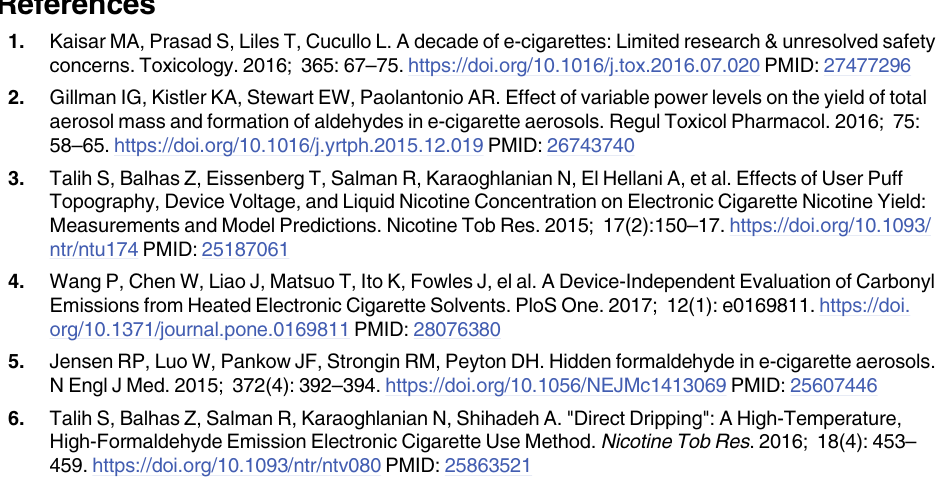
S1 Table. Corresponding statistic (Anova) for TC measurements presented in S3 Fig at the top and mid-section of atomizer B for the three different applied mods (mod_1, mod_2, mod_3) at the selected time points of: 1 s, 3 s, 5 s, 7s, and 9 s. Note: An analysis of variance for 5 different time points showed that in 8 of the 10 comparisons, no significant difference was discernable. Essentially, the variation within tests of a single mod exceeded the variation between